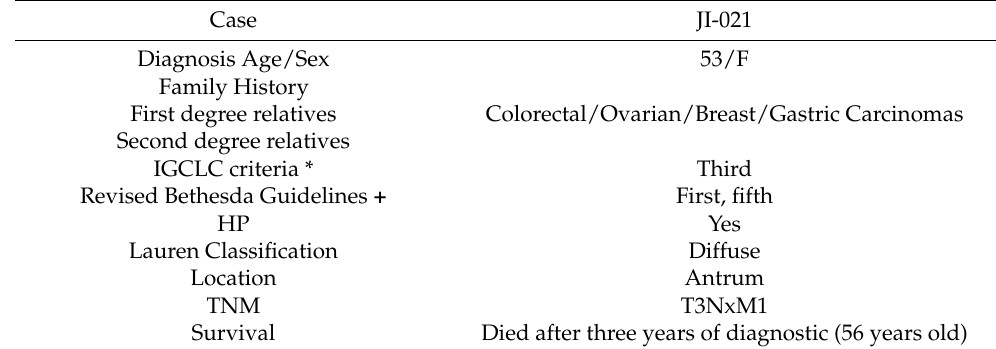
Table 1. Description of clinicopathological features and family history of the index